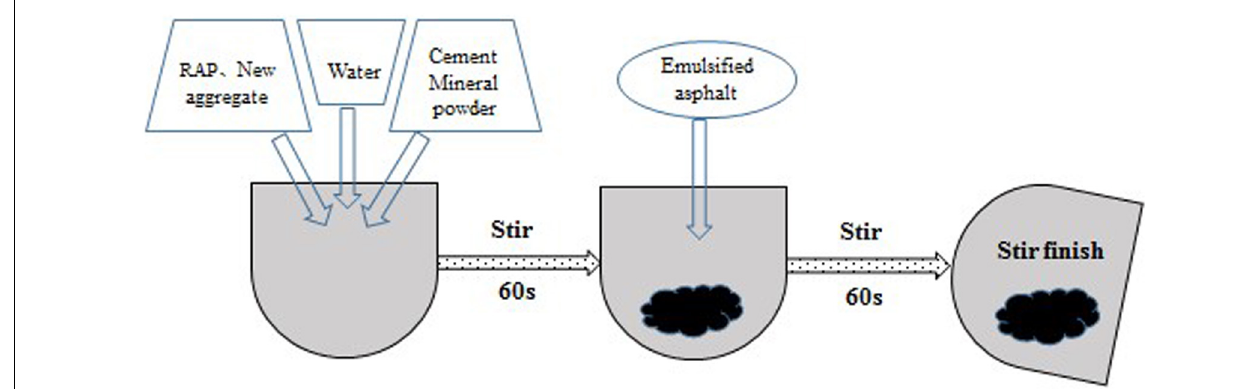
FIGURE 2 | Traditional mixing process.